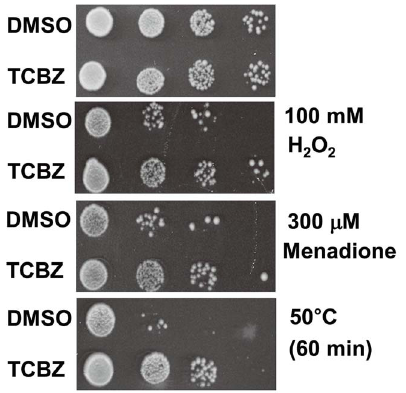
Figure 2. Triclabendazole protects cells from oxidative and heat stresses. Triclabendazole (5 m M) or vehicle was added to diluted cells in SC-glucose medium, and then cells were incubated at 30 u C with shaking for 4 days. Cells were removed from the culture, serially diluted in PBS, incubated with oxidant or heated and spotted onto YPD plates. Plates were incubated at 30 u C for 3 days. 5 m M triclabendazole boosted life span by over 100 % compared to untreated cells (Fig. 3D). Thus, triclabendazole at 5 m M extends the chronological life span of yeast cells without disrupting mitotic spindles. Collectively, at high concentrations ( . 10 m M) triclaben- dazole disrupts microtubules and is toxic, whereas at lower concentrations (2-5 m M) the drug does not disrupt microtubules and is cytoprotective.